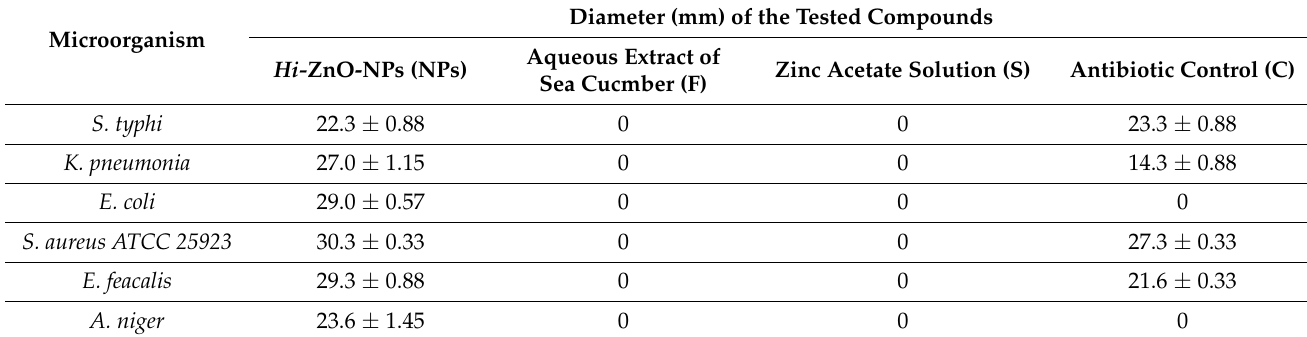
Table 2. Antimicrobial potential of biosynthesized Hi -ZnO-NPs. Mean ± SD of Inhibition Zone Diameter (mm) of the Tested Microorganism